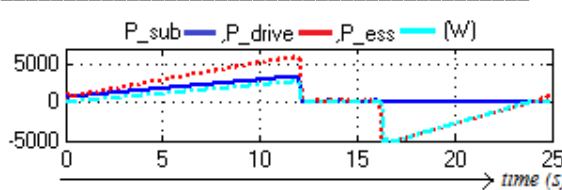
Fig. 13. Simulation diagram of power for both C = 31.5 F and C = 63 F.